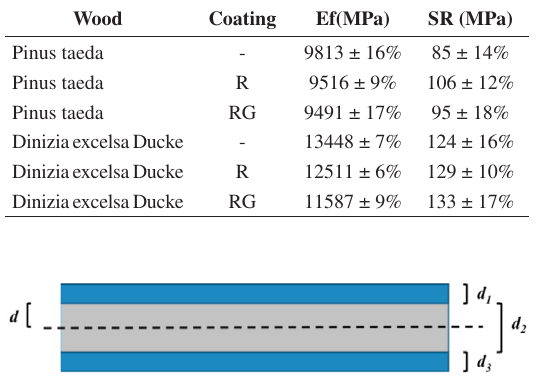
Figure 8. Shematic cross-section of the coated strucuture with respective thickness